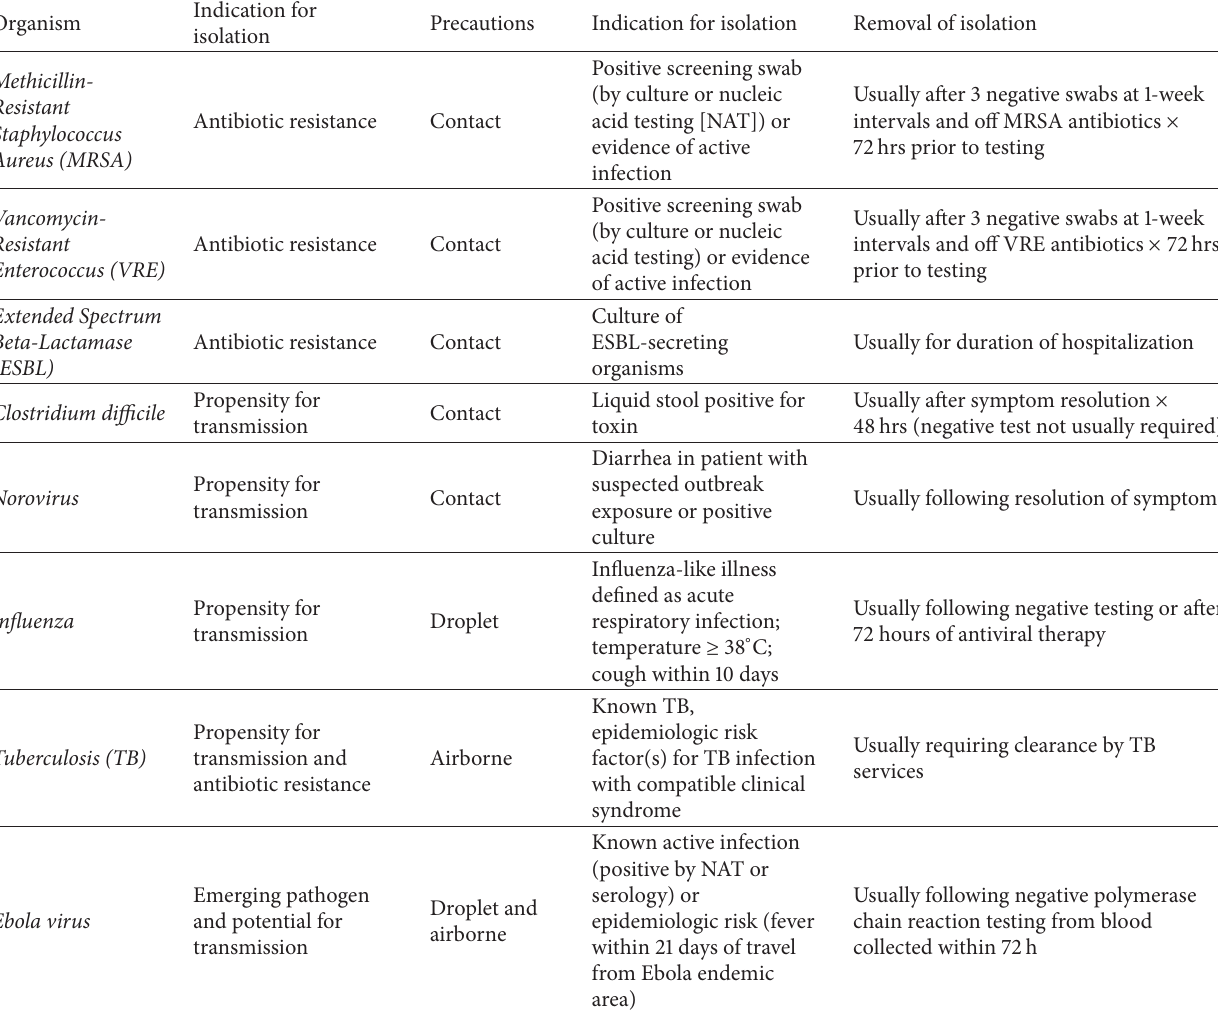
Table 1: Typical isolation precautions and deisolation recommendations for various microorganisms. Adapted from [3] Siegel et al. and [8] Huang et